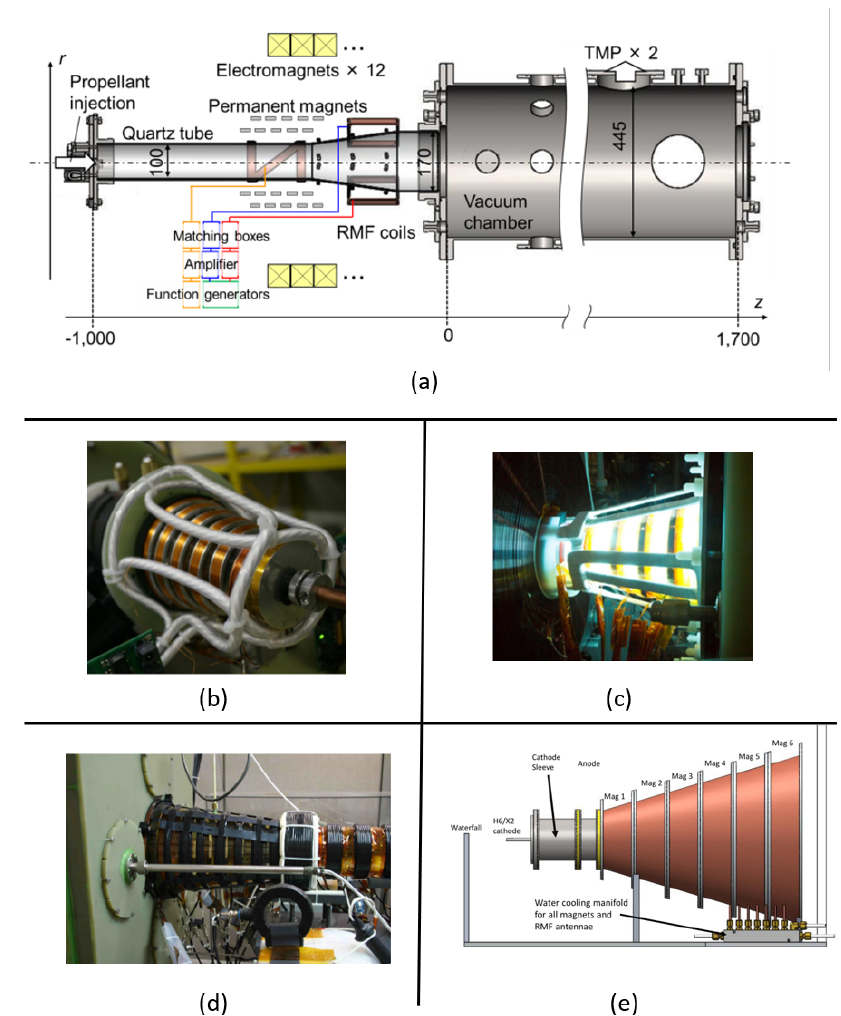
Figure 11. RMF-FRC test articles: ( a ) Schematic of Tokyo University electrodeless helicon plasma electromagnetic plasma thruster (from [47]; reproduced with permission of the author), ( c ) Air Force Research Laboratory RP3-X thruster (from [49]), ( d ) MSNW electrodeless Lorentz force